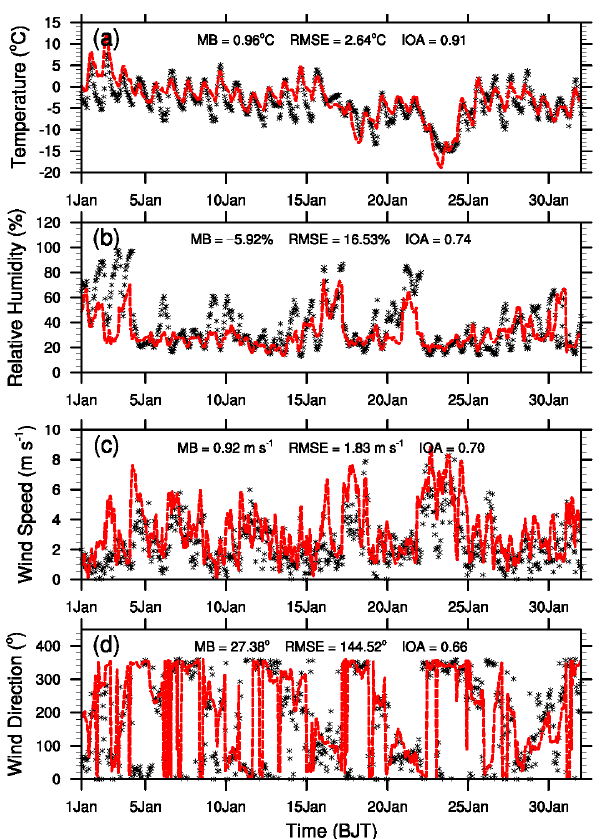
Figure 3. Comparisons between observed (black dots) and simulated (solid purple line) diurnal profiles of ( a ) near-surface temperature, ( b ) relative humidity, ( c ) wind speed, and ( d ) wind direction at meteorological sites in Beijing from 1 to 31 January 2016.